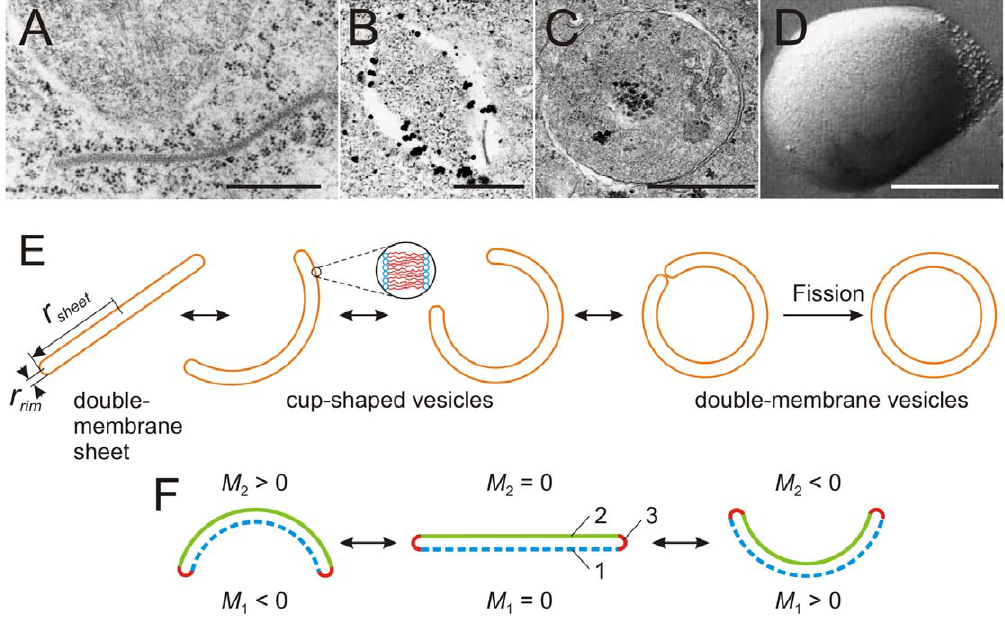
Figure 2. Cellular double-membrane organelles at different stages of their genesis. (A–D) electron microscopy micrographs, (E) schematic illustration of the sequence of shape changes, and (F) schematic cross section of the sheet with possible bending directions. (A) A growing double- membrane sheet during spore formation in Schizosaccharomyces pombe , [2]. (B) A cup-shaped phagophore with immunogold label (black spots) for the mammalian Atg8 homologue GATE16 [51]. (C) A closed autophagosome with the double membrane clearly visible [50]. (D) A freeze-fracture electron micrograph showing the smooth autophagosomal membrane. In the upper right corner a small, particle-rich endosome had fused with the autophagosome [47]; the smooth surface of the autophagosome away from the fusion area suggests the absence of a protein coat. All scale bars correspond to 0.5 m m. The electron microscopy images were adapted with permissions of the J. Cell Sci. and Elsevier. (E) Schematic illustrations of the shape transition from a double-membrane sheet to a double-membrane vesicle (cross sections shown). The solid line represents one bilayer. Geometrical parameters used in the main text are indicated in the first cartoon. The transition between the flat sheet and the vesicle can be reversible. The final step of generating the double-membrane vesicle requires irreversible fission. (F) Schematic cross sections of the sheet and cup- shape morphologies. Three different segments of the shapes are distinguished: lower segment (1, dashed blue), upper segment (2, solid green), and highly curved rim (3, solid red). The sheet (middle) is characterized by zero mean curvatures of the upper and lower segments, M 1 = M 2 =0. When the sheet bends downwards (left), the mean curvature of the lower segment is negative, M 1 , 0, and that of the upper segment is positive, M 2 . 0. The situation is reversed when the sheet bends upwards